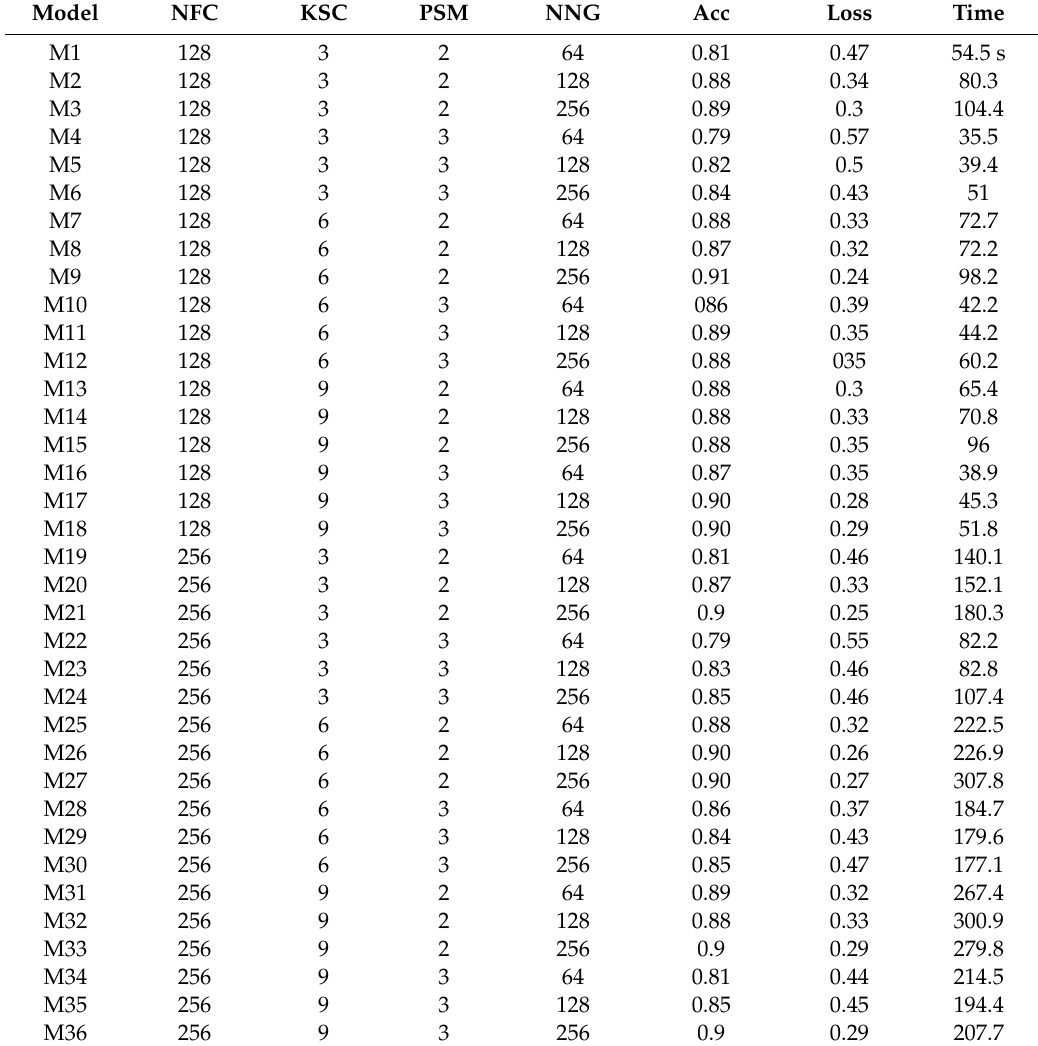
Table 4. Parameters listed with the training time, loss, and accuracy of model performance.